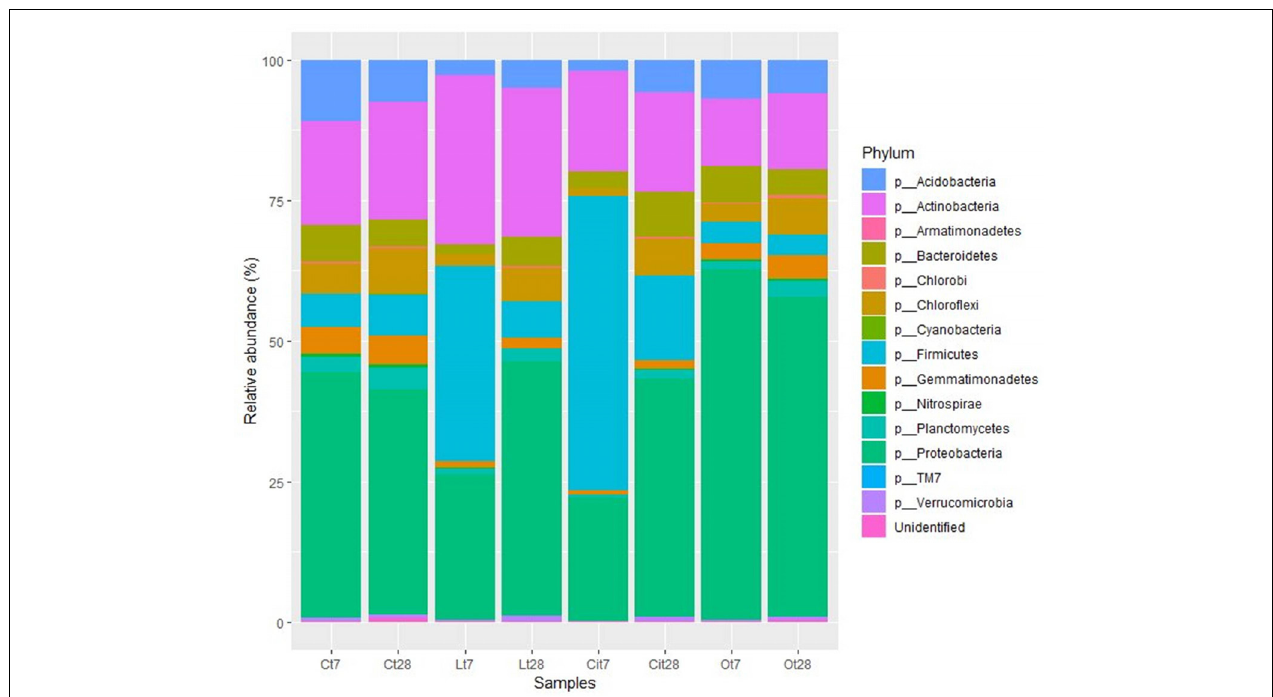
FIGURE 7 | Bacterial community composition at phylum level. Sequences that could not be classified into any known group were designated “Unidentified.” C, control sample; L, lactic acid treated sample; O, oxalic acid treated sample; Ci, citric acid treated sample. t7: day 7; t8: day 28.